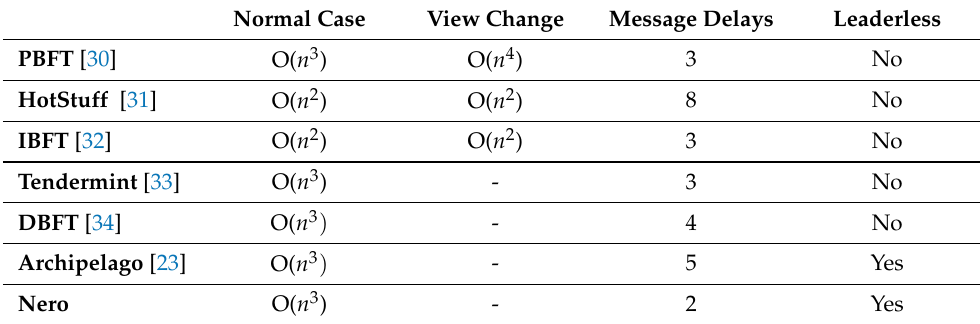
Table 1. Comparison of different consensus